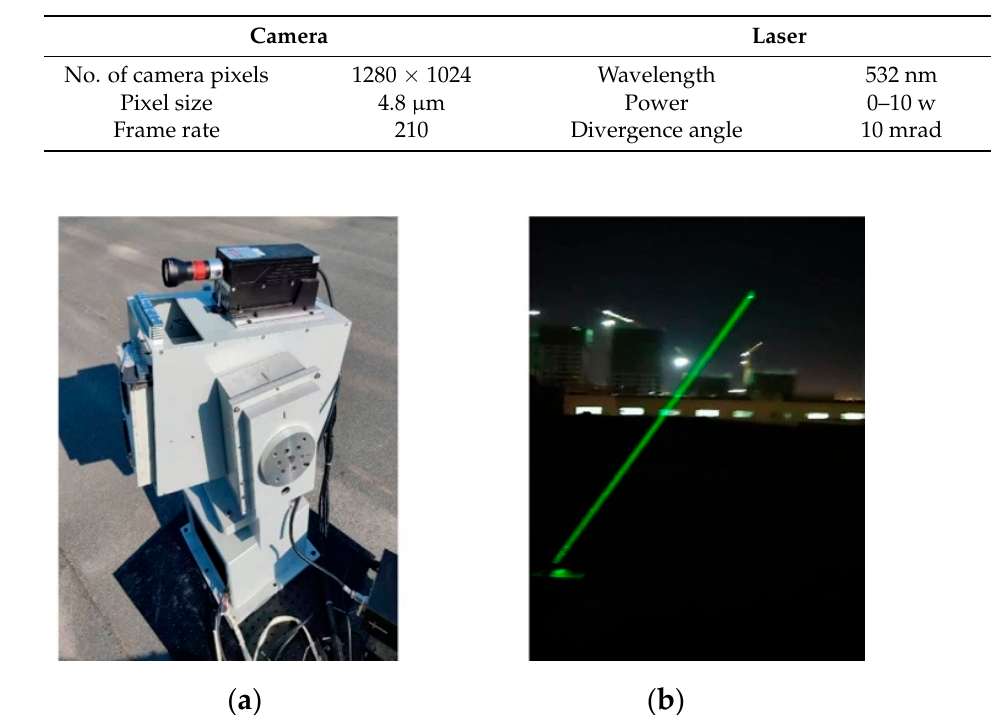
Figure 5. Photograph of experimental devices ( a ) and experimental scene ( b ).